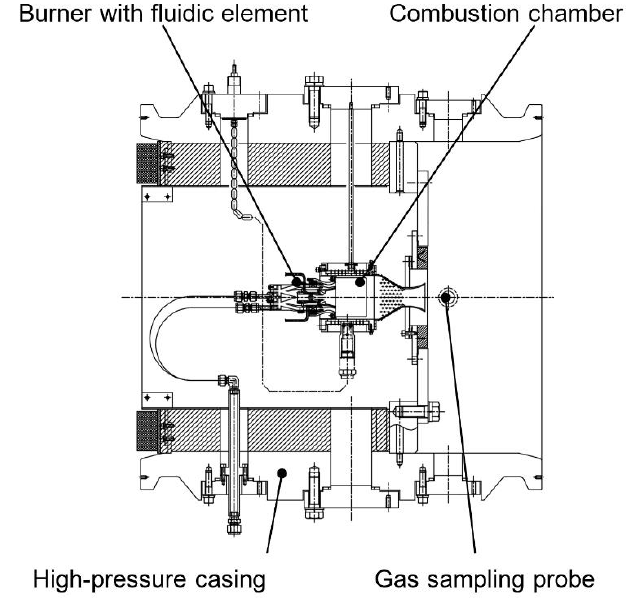
Figure 5. Experimental arrangement used for exhaust gas analysis. (Copyright by ASME — "Effects of Fluidic Control of Air-Flow Distribution on Staged Lean Jet Engine Burner," by Yoshida, Schneider, Hassa, Paper No: GT2016-57453).